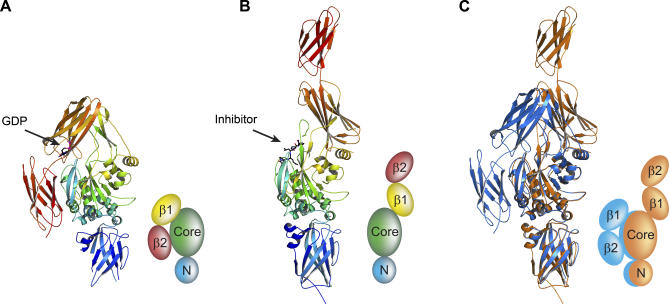
Overall Structures of GDP-Bound and Inhibitor-Bound TG2The crystal structures are shown as ribbons, and simplified cartoons are included for clarity.(A and B) The N-terminal β-sandwich is shown in blue (N), the catalytic domain (Core) in green, and the C-terminal β-barrels (β1 and β2) in yellow and red, respectively. (A) GDP-bound TG2 [16]. (B) TG2 inhibited with the active-site inhibitor Ac-P(DON)LPF-NH2.(C) The N-terminal β-sandwich and catalytic domains of the two structures are superimposed, highlighting the conformational change. The GDP-bound structure is shown in blue and the inhibitor-bound structure in gold.